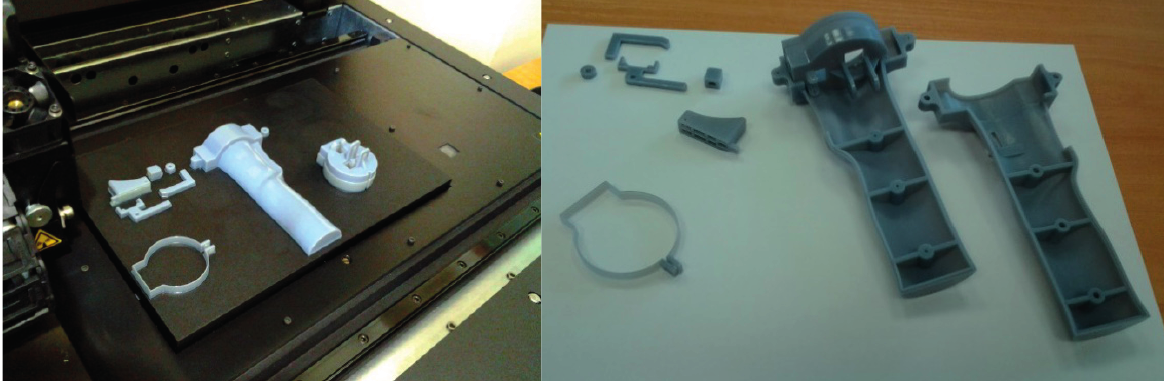
Figure 5. ( Left ) Synchronization system components manufacturing; ( Right ) Cleaned